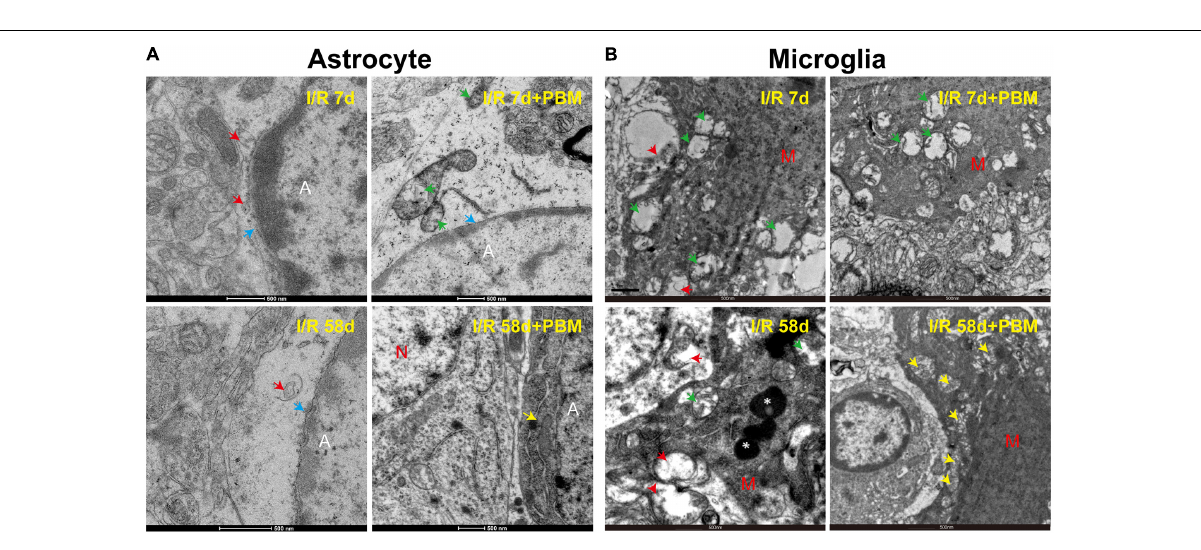
FIGURE 7 | The effects of PBM on astrocyte and microglia ultrastructure in the hippocampal CA1 region of I/R 7 days and I/R 58 days animals. Representative electron microscopy images show the ultrastructure of astrocytes (A) and microglia cells (B) in the indicated groups. Yellow arrows: integrity mitochondria; red arrows: disaggregated mitochondria; green arrows: mitochondria with broken cristae; white star: lysosome; blue arrows: nuclear membrane. A, astrocyte; M, microglia; N,